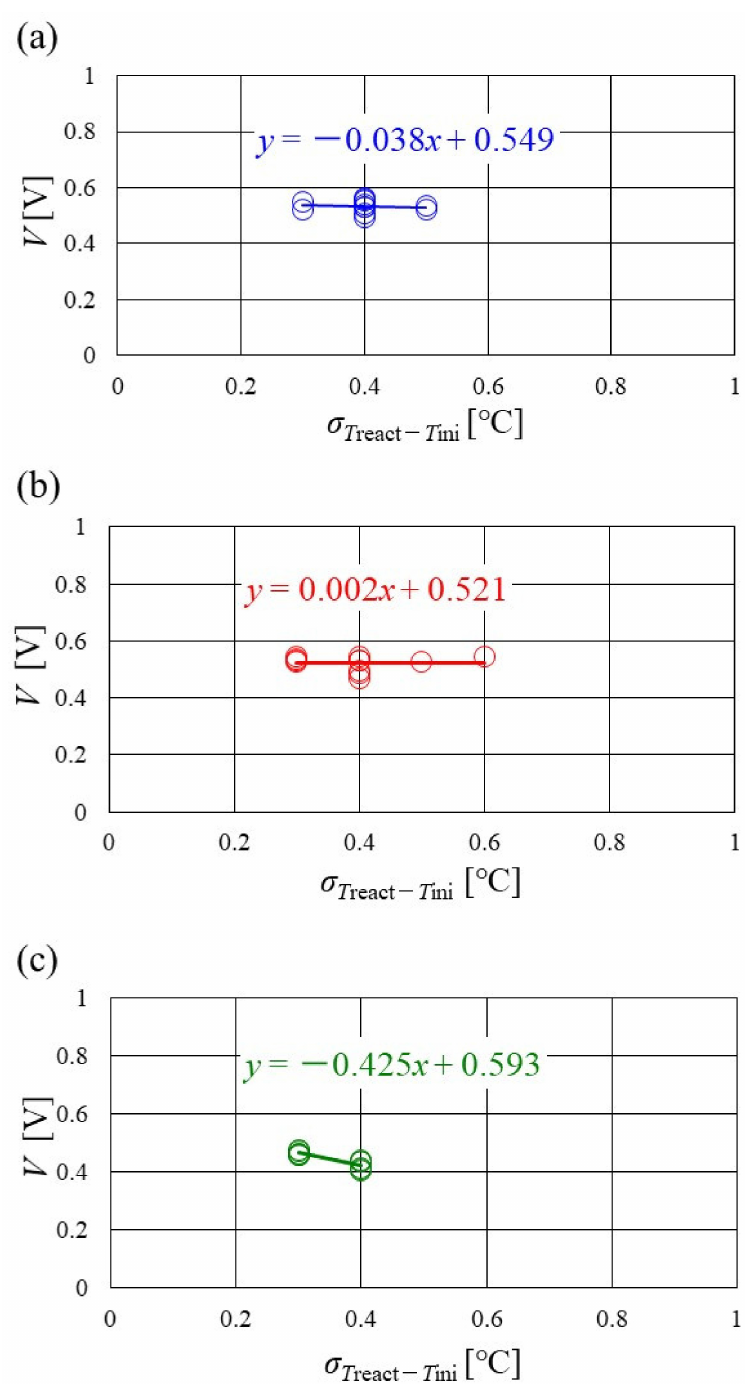
Figure 16. Relation between standard deviation of distribution of temperature difference, between temperature at reaction surface and initial operation temperature and total voltage, in the case of a separator thickness of 2.0 mm: ( a ) the initial operation temperature = 80 ◦ C, ( b ) the initial operation temperature = 90 ◦ C, ( c ) the initial operation temperature = 100 ◦